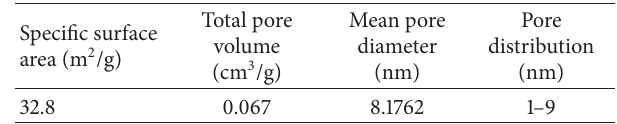
Table 4: The properties of the unsupported anatase membrane obtained of BET